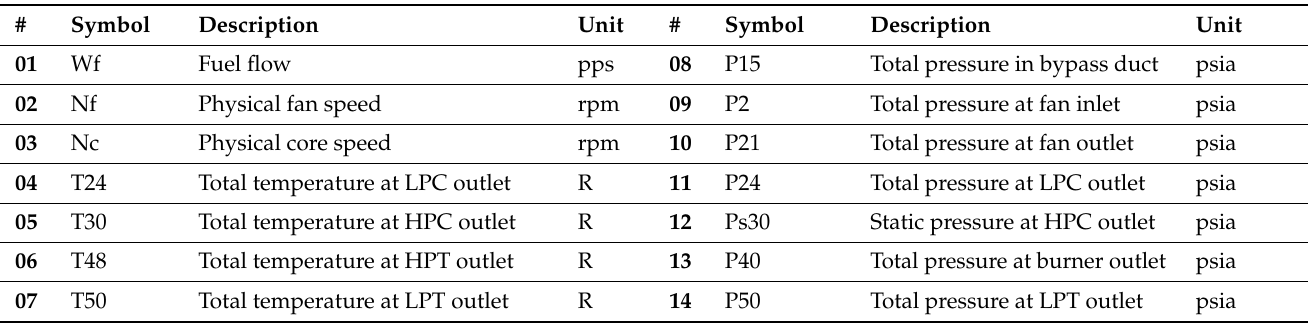
Table 2. Sensors physical properties.